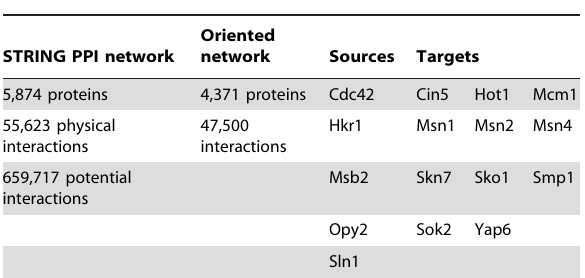
Table 1. Data and